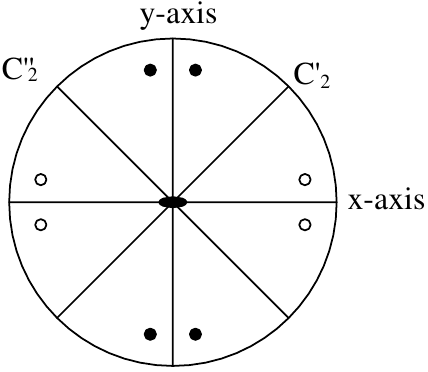
FIG. 8. Stereogram of the point group D black circles indicate the points above and below the sheet, respectively. Note that the group D similar figure with 45 (cid:21) rotation.